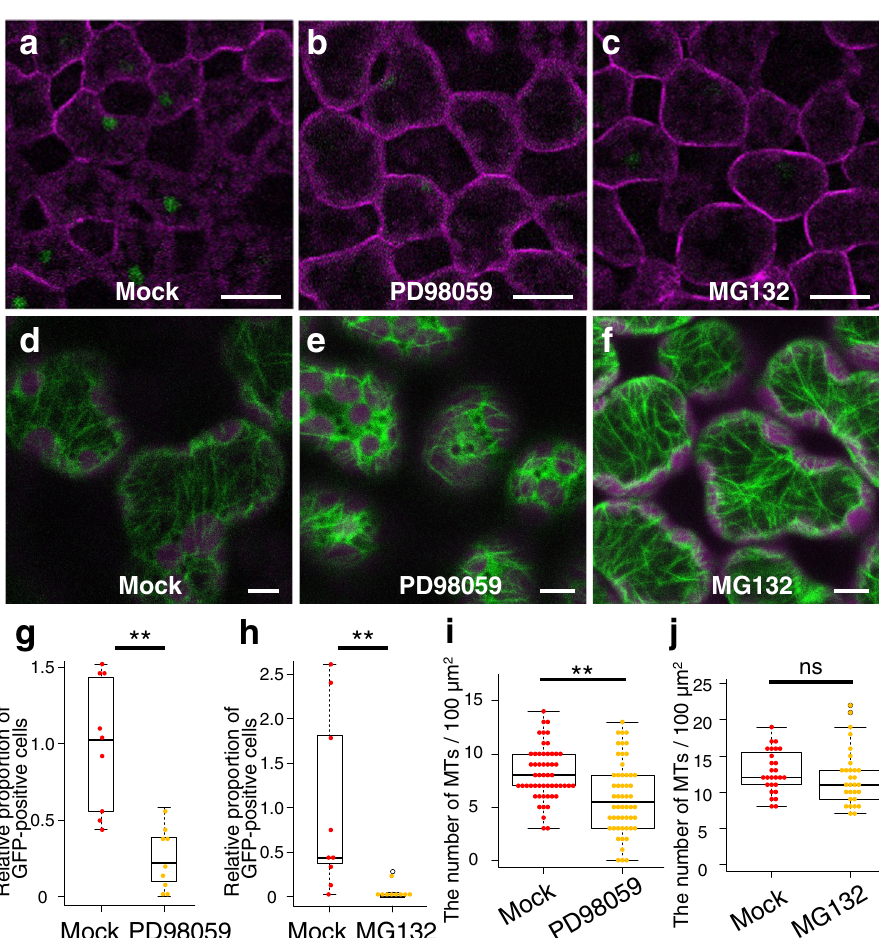
Fig. 4 | MAPK signaling and proteasome activities were required for ATML1 derepression in the outermost mesophyll cells. a – c Mesophyll cells of the epidermis-peeled fi rstorsecondleavesin10-day-old proATML1-nls-3xGFP seedlings grown in liquid MS medium supplemented with 0.1% DMSO ( a , Mock), 25 µ M MAPKK inhibitor PD98059 ( b , PD98059) or 10 µ M proteasome inhibitor MG132 ( c , MG132) for 24h after surgery. d – f GFP-TUA6 protein localization in the outer- most mesophyll cells of 9-day-old seedlings grown in liquid MS medium supple- mentedwith0.1%DMSO( d ),25 µ MPD98059( e )or10 µ MMG132( f )forthreehours aftersurgery.Eachexperimentwasrepeatedthreetimesfor a – e andtwicefor f with similar results. g , h The relative proportion of the outermost mesophyll cells showing proATML1-nls-3xGFP signals above the threshold was quanti fi ed in mock, PD98059 or MG132-treated seedlings at 1 dar. n =nine biologically independent